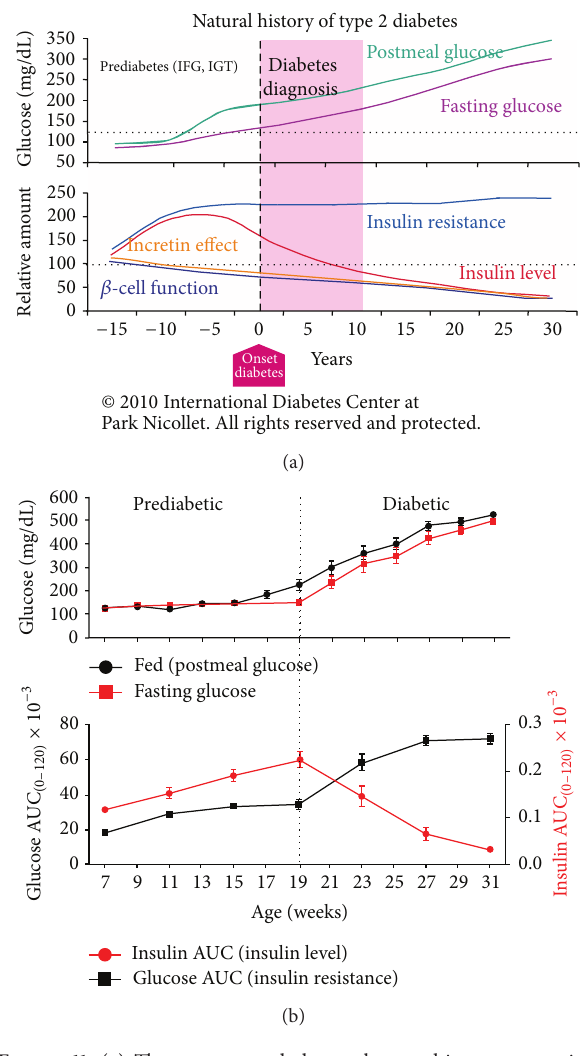
Figure 11: (a) The upper panel shows the graphic representation of the progression of both fasting and postmeal hyperglycemia. The lower panel demonstrates both insulin resistance and defective beta-cell function (Natural History of Type 2 Diabetes © 2010, International Diabetes Center, Minneapolis, MN, USA, used with permission). (b) demonstrates the similarity between the progres- sion of diabetes between the human condition and ZDSD rat. The vertical dotted line represents the onset of